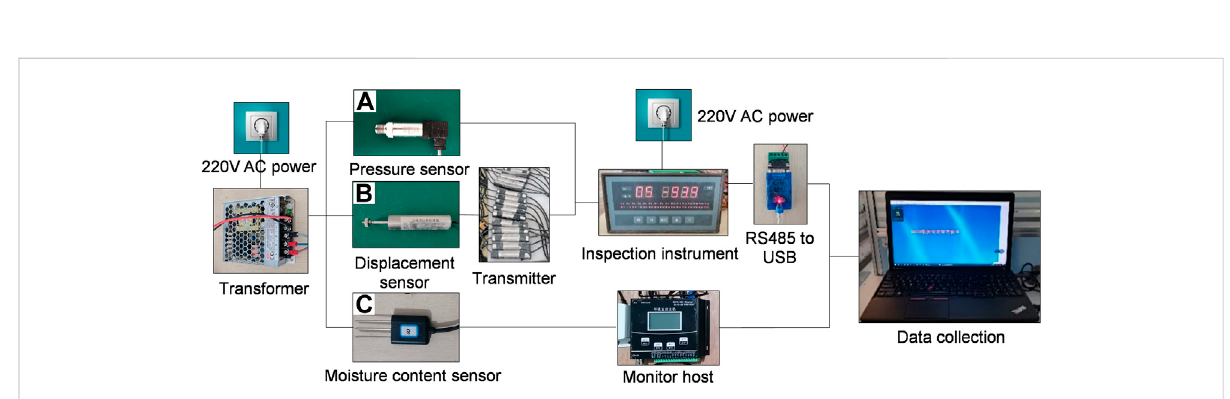
FIGURE 4 System diagram of monitoring data transmission. (A) Pressure, (B) displacement, and (C)